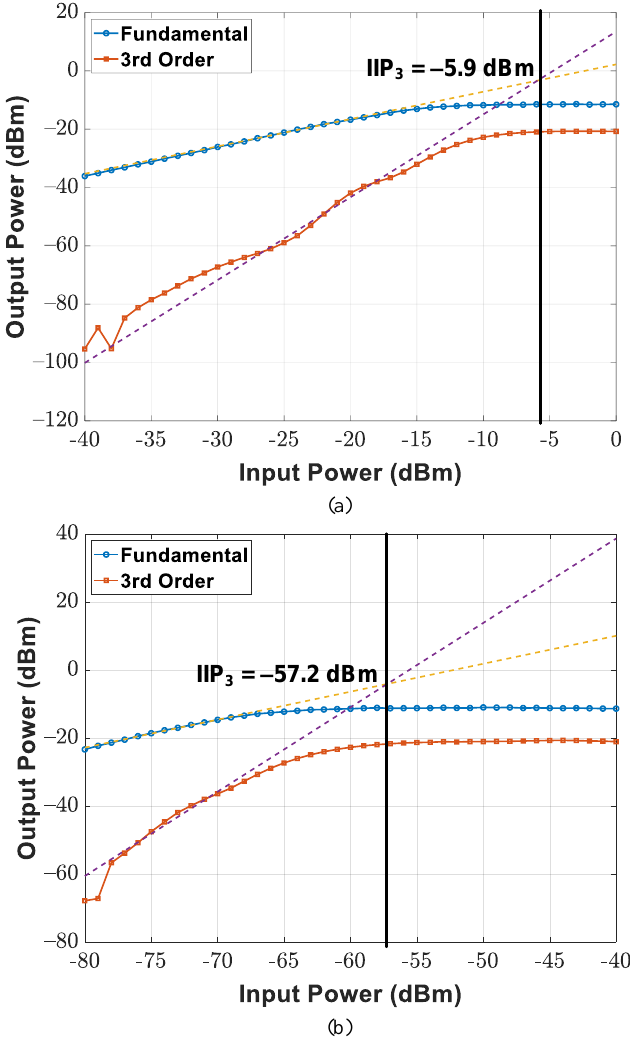
Figure 24. Third-order intercept point ( IP 3 ) of the implemented receiver for ( a ) lowest conversion gain and ( b ) highest conversion